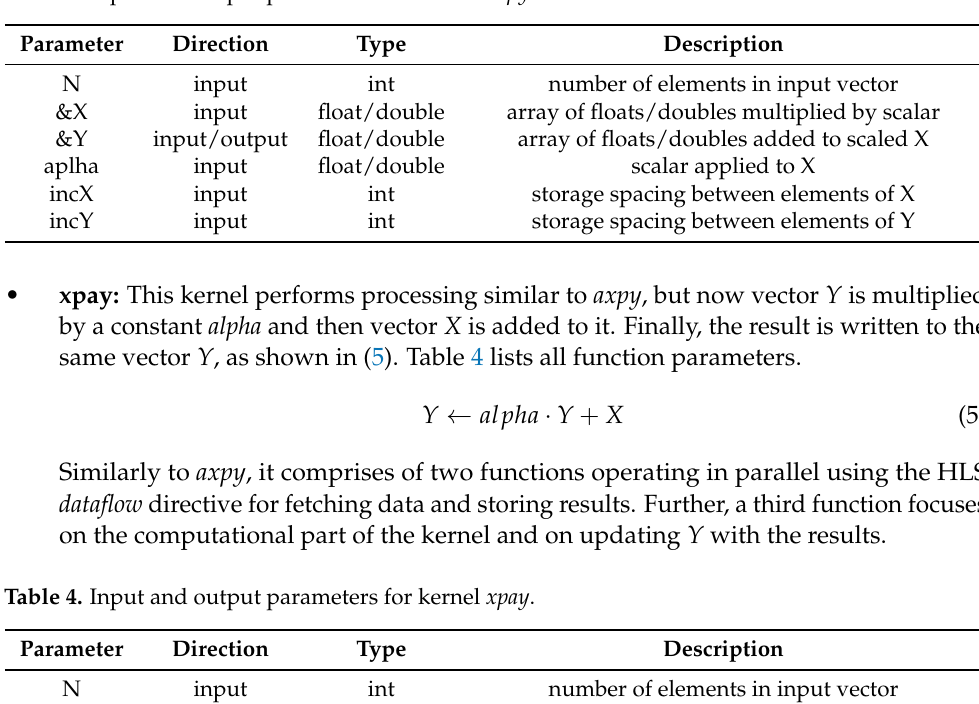
Table 3. Input and output parameters for kernel axpy .